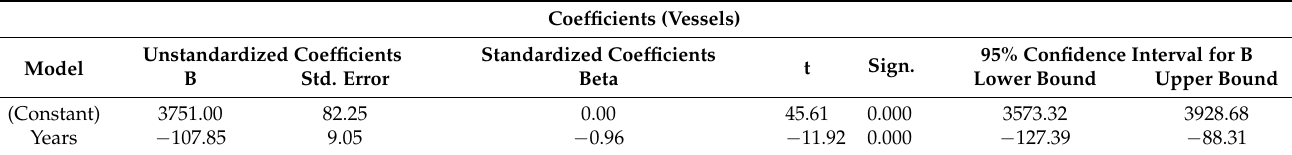
Table 5. The regression coefficients of the vessels’ linear model estimation.